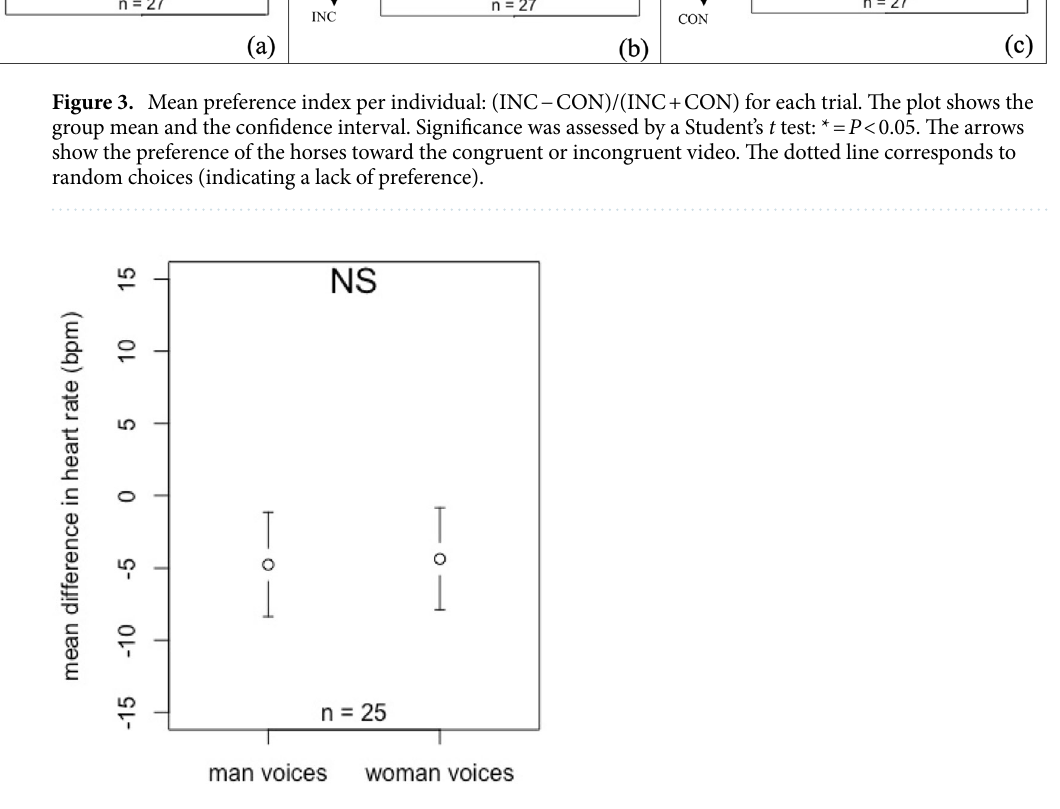
Figure 4. Effect of the voice (man’s or woman’s voice) on the heart rate of horses: mean individual differences between the mean heart rate of the last 5 s and the first 5 s of each trial. The plot shows the group means and the confidence interval. Significance was assessed by a Student’s t